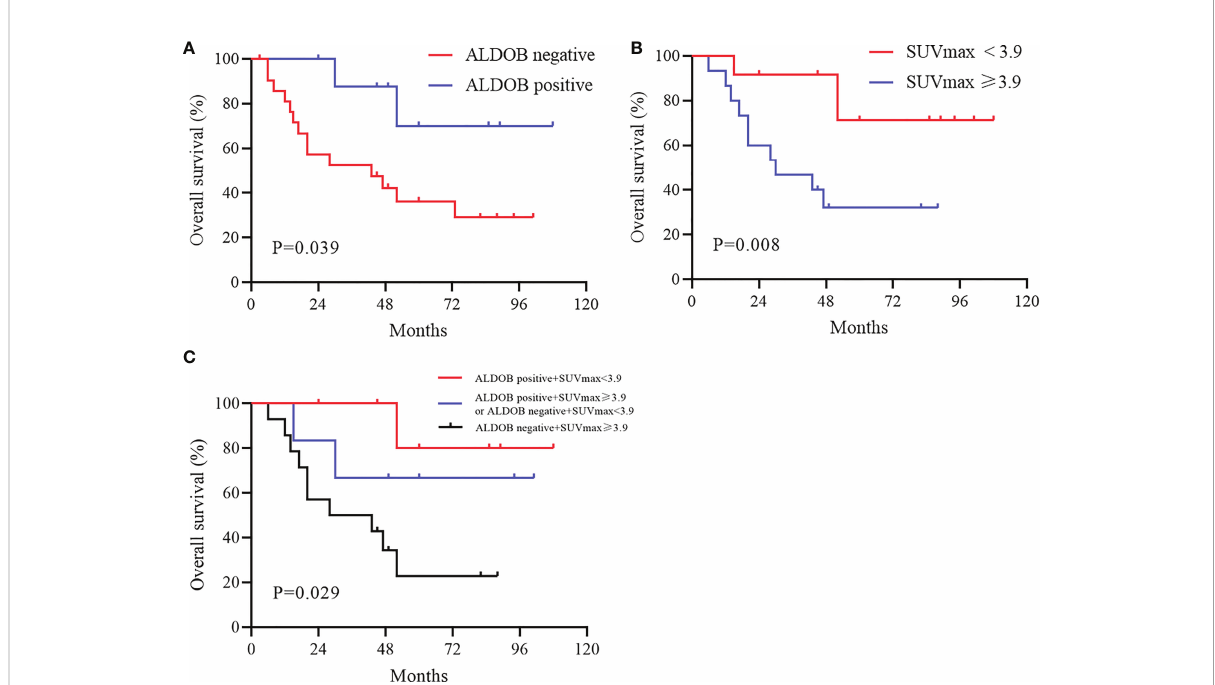
FIGURE 4 Kaplan-Meier overall survival curve in patients with HCC. (A) Patients with positive ALDOB expression had longer overall survival than those with negative ALDOB expression (88.5 ± 11.7 months versus 49.2 ± 8.4 months; P=0.039). (B) Patients with SUVmax ≥ 3.9 had signi fi cantly shorter